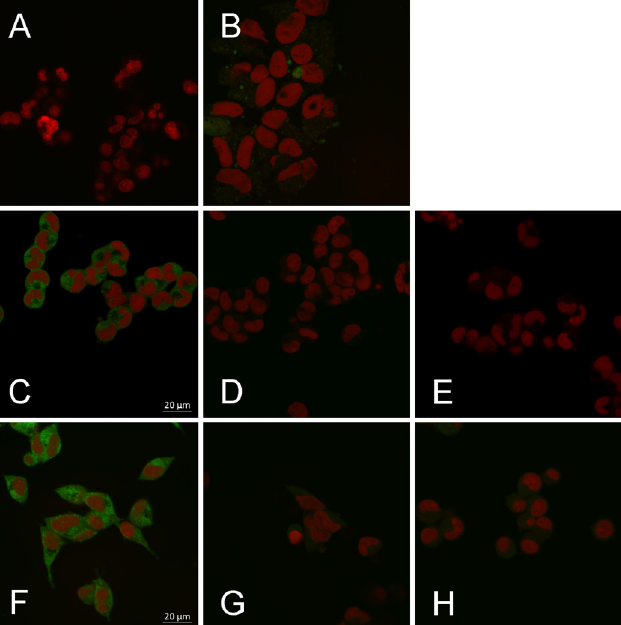
Fig 6. Confocal laser scanning microscopy of cellular ASP + uptake via OCT1 and OCT3. Uptake of fluorescent ASP + [1 μ M] (green) in the absence and presence of compound 5 or TPA after 5 minutes of pre- incubation. Nuclei were stained with Draq5 [5 μ M] (red). A, B: HEK-Co (control) cells, treated with Draq5 (A) or ASP + plus Draq5 (B). C-E: HEK-OCT1 cells, treated with ASP + plus Draq5 (C), ASP plus Draq5 plus compound 5 [15 μ M] (D), or ASP + plus Draq5 plus TPA [200 μ M] (E). F-H: HEK-OCT3 cells, treated with ASP + plus Draq5 (F), ASP + plus Draq5 plus compound 5 [15 μ M] (G), or ASP + plus Draq5 plus TPA [200 μ M]